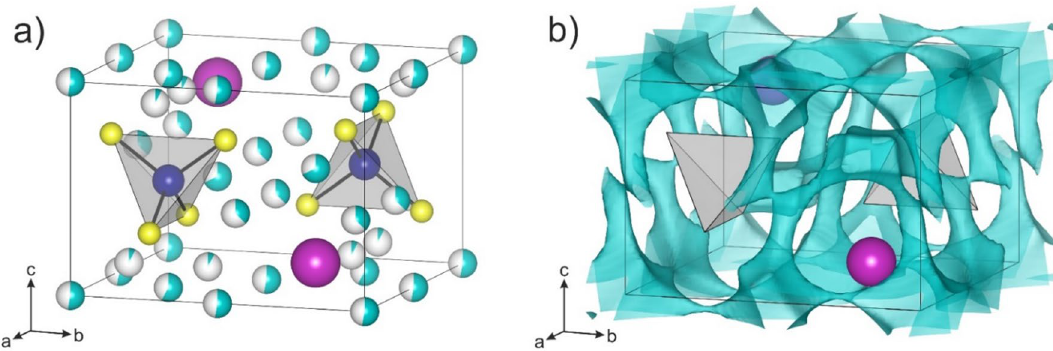
Figure 1. ( a ) Structure of Li 4 PS 4 I crystallizing in the P 4/ nmm space group. Li, P, S and I atoms are shown as cyan, blue, yellow and purple spheres, respectively. ( b ) Bond-valence energy landscape showing the 3-dimensional lithium diffusion pathways. For clarity, Li, P and S atoms are omitted. PS 43− tetrahedra and I atoms are shown in gray and as purple spheres,